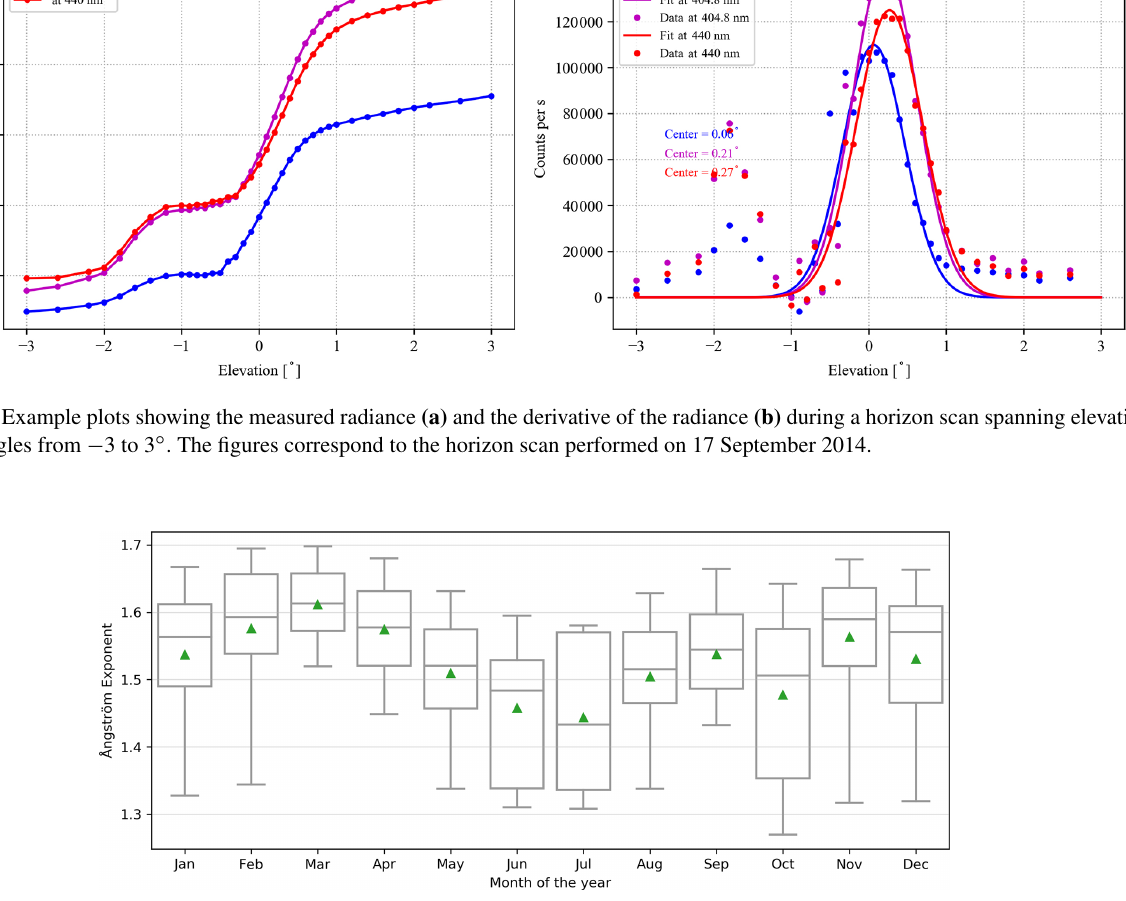
Figure F4. Monthly variation in Ångström exponent for the wavelength pair 470 and 550nm derived from MODIS measurements over Mohali. The green triangles represent the monthly means. The centre line of each box represents the median values, whereas the box represents the interquartile range. The whiskers represent the 5th and 95th